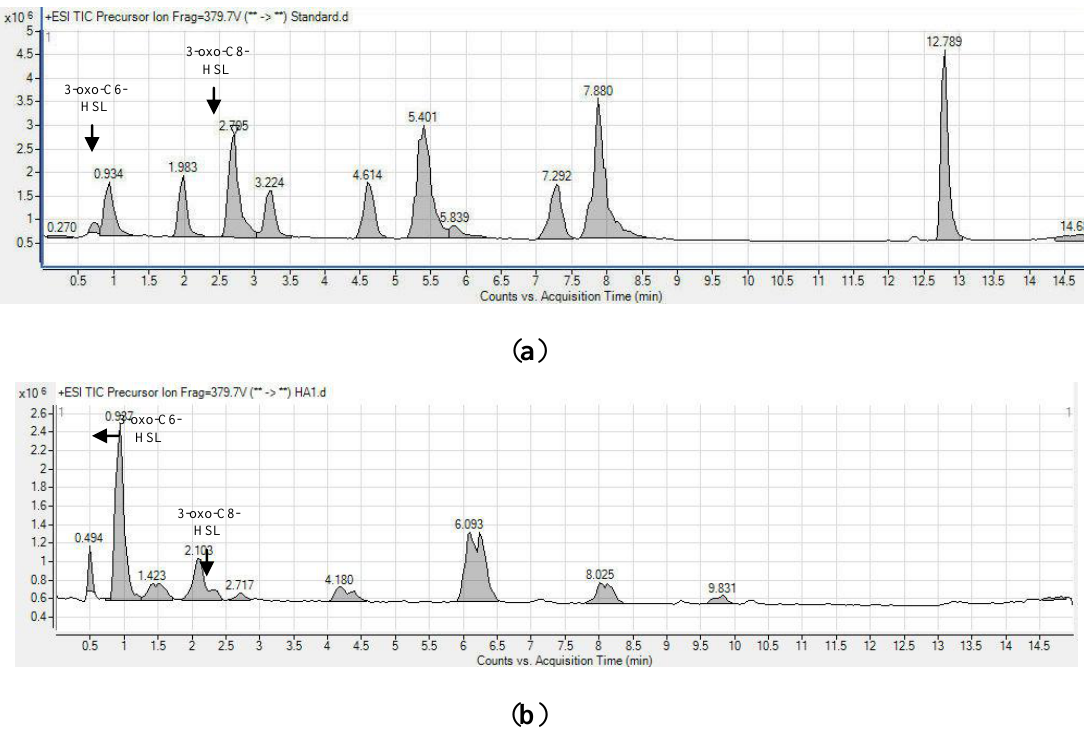
Figure 3. Chromatograms showing the peaks of targeted AHLs (3-oxo-C6-HSl, 3-oxo-C8-HSL, marked by arrows) ( a ) Synthetic AHL standards (1 ppm each); ( b ) AHLs extracted from the cell-free supernatant of H. alvei FB1